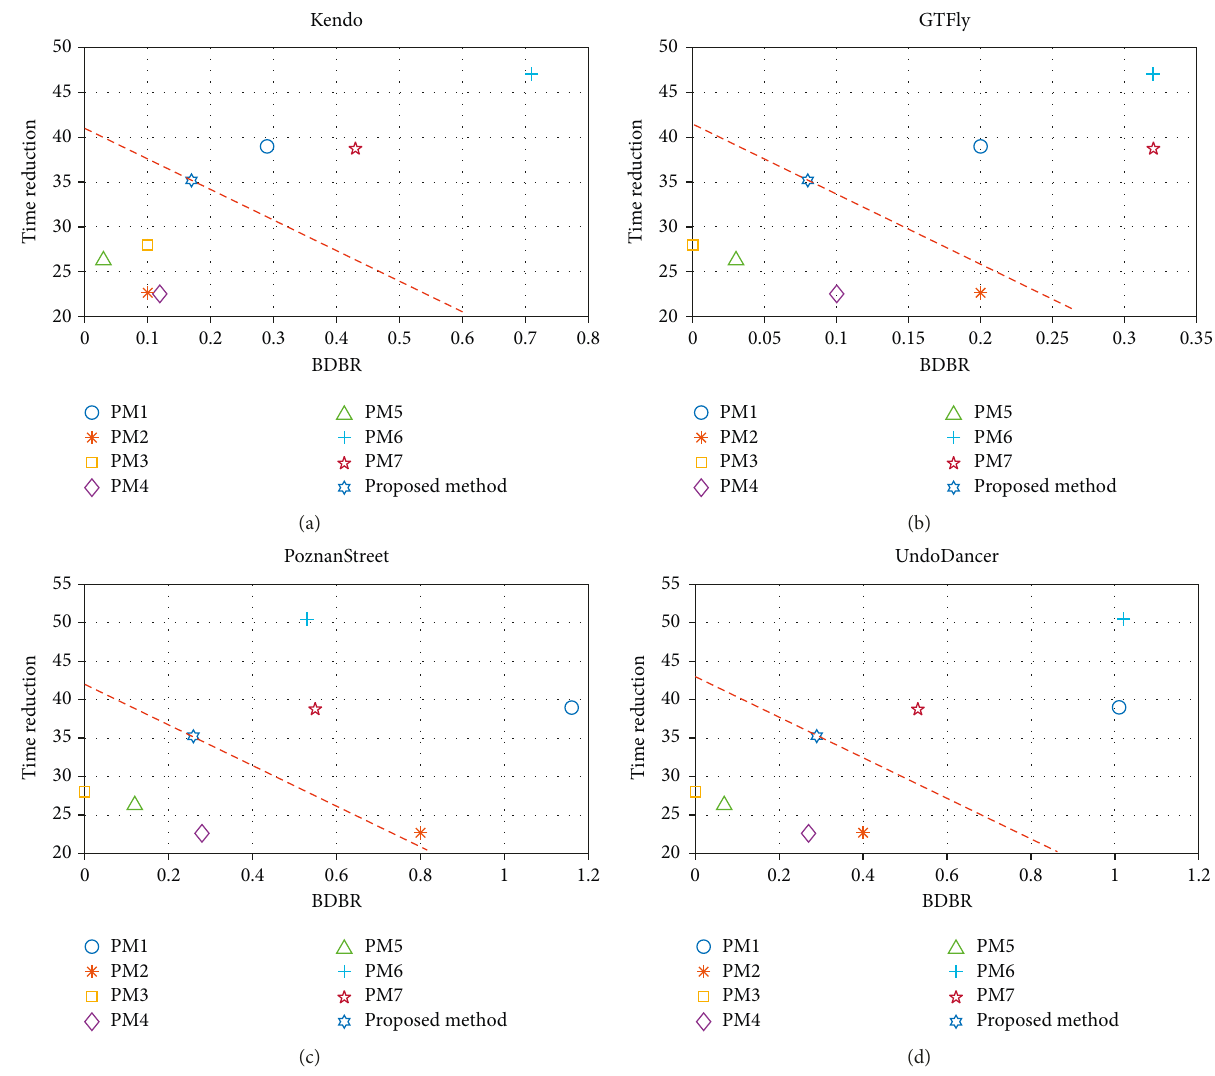
Figure 7: BDBR in function for time reduction of Kendo, GTFly, PoznanStreet, and